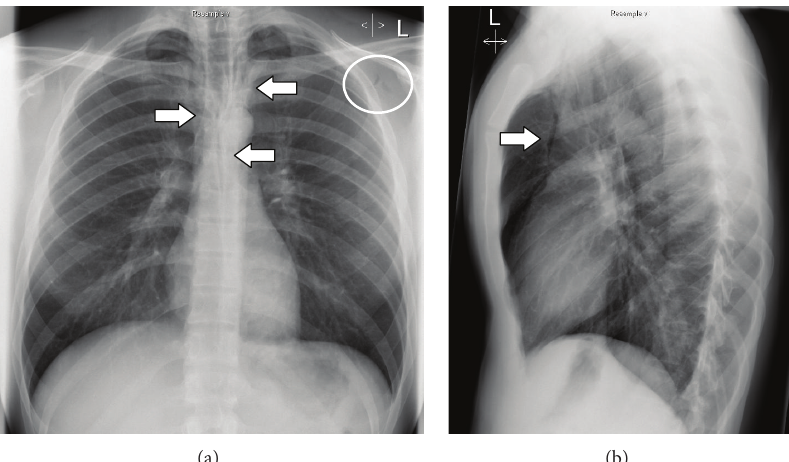
Figure1:ChestX-rayshowingairoutliningmediastinalstructures(arrows)andsubcutaneousemphysemaintheareaoftheleftaxilla(circle).